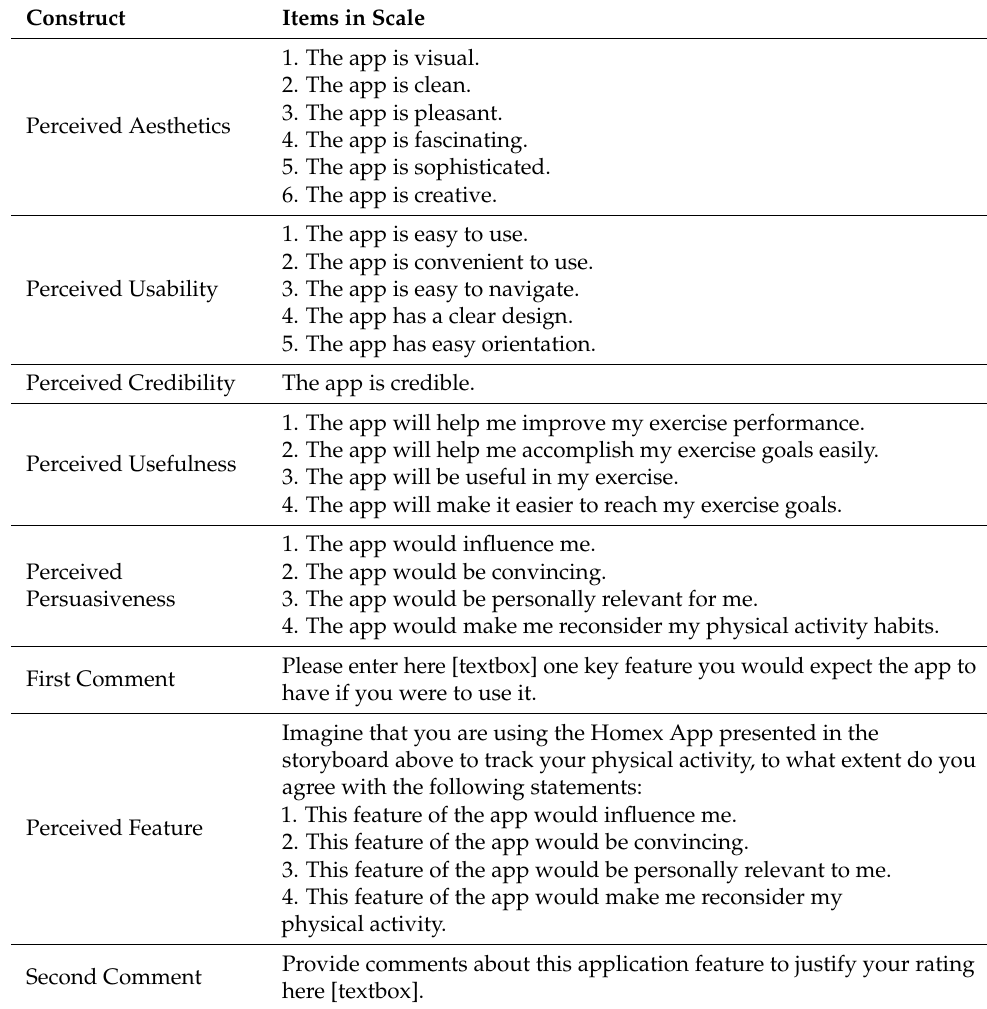
Table 3. Study’s constructs and measurement items